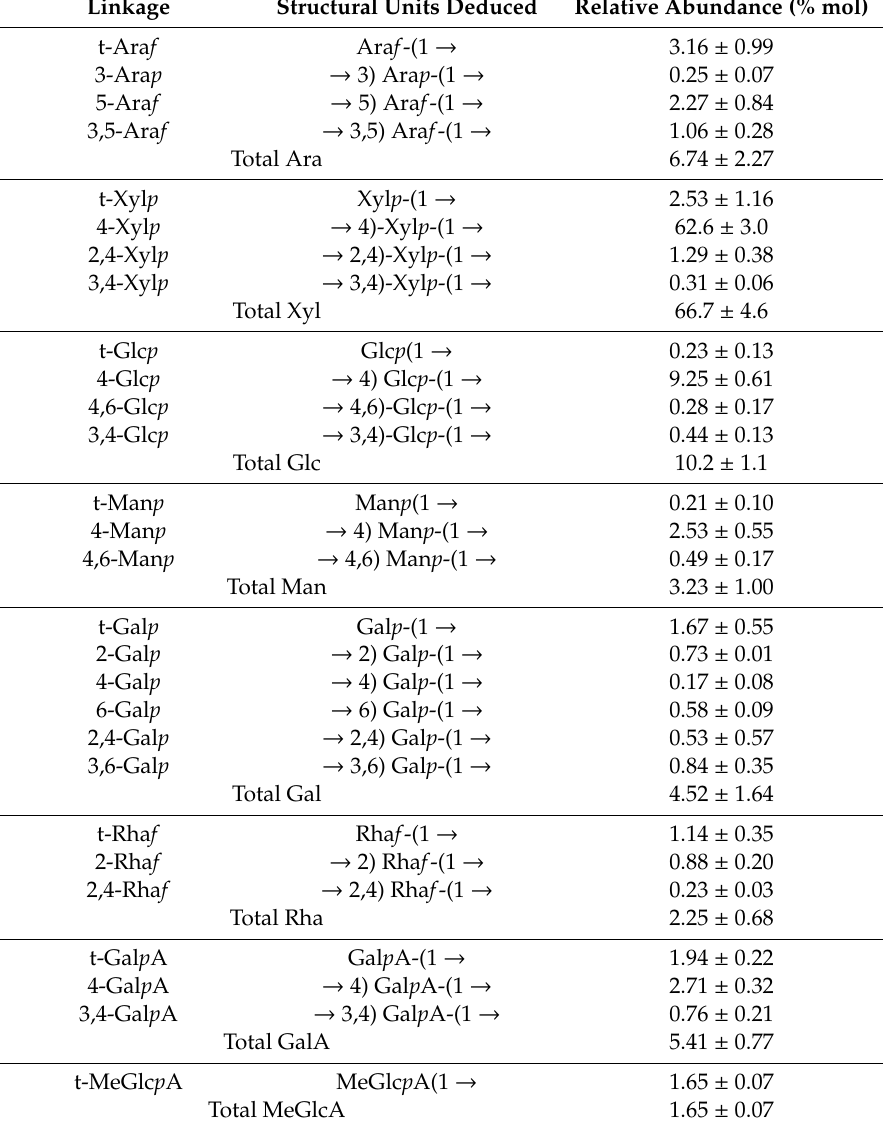
Table 2. Carbohydrate linkage analysis of PSP ( n = 3, mean ±